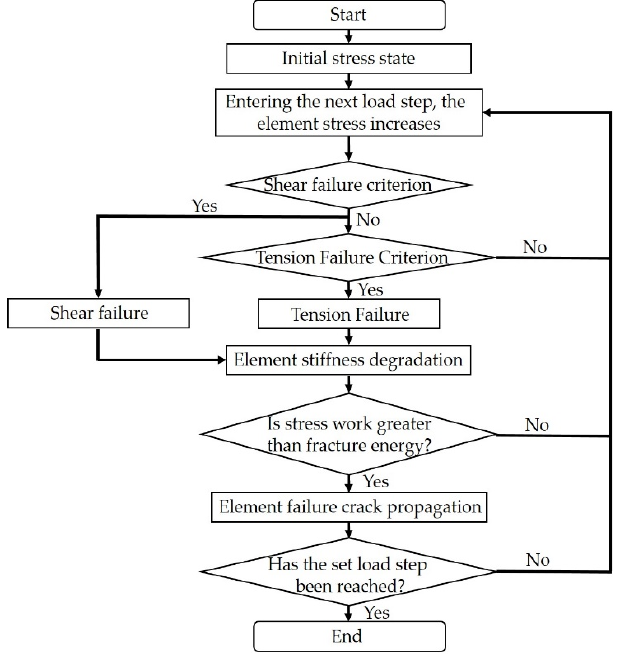
Figure 4. Process of tension-shear fracture criterion.